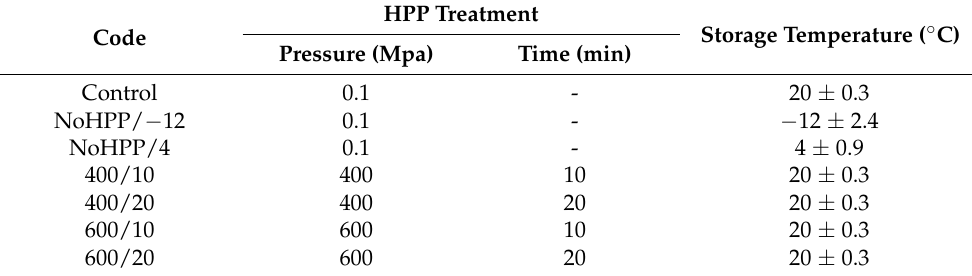
Table 1. Summary of the processing and storage conditions for the chocolate fillings. HPP Treatment Storage Temperature ( ◦ C) Code Pressure (Mpa) Time (min) Control